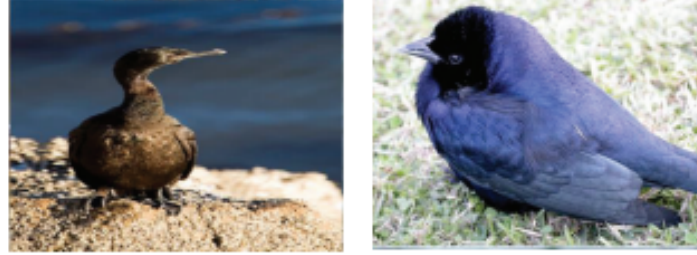
Figure 3. Examples from Caltech-UCSD-Birds (CUB) dataset.